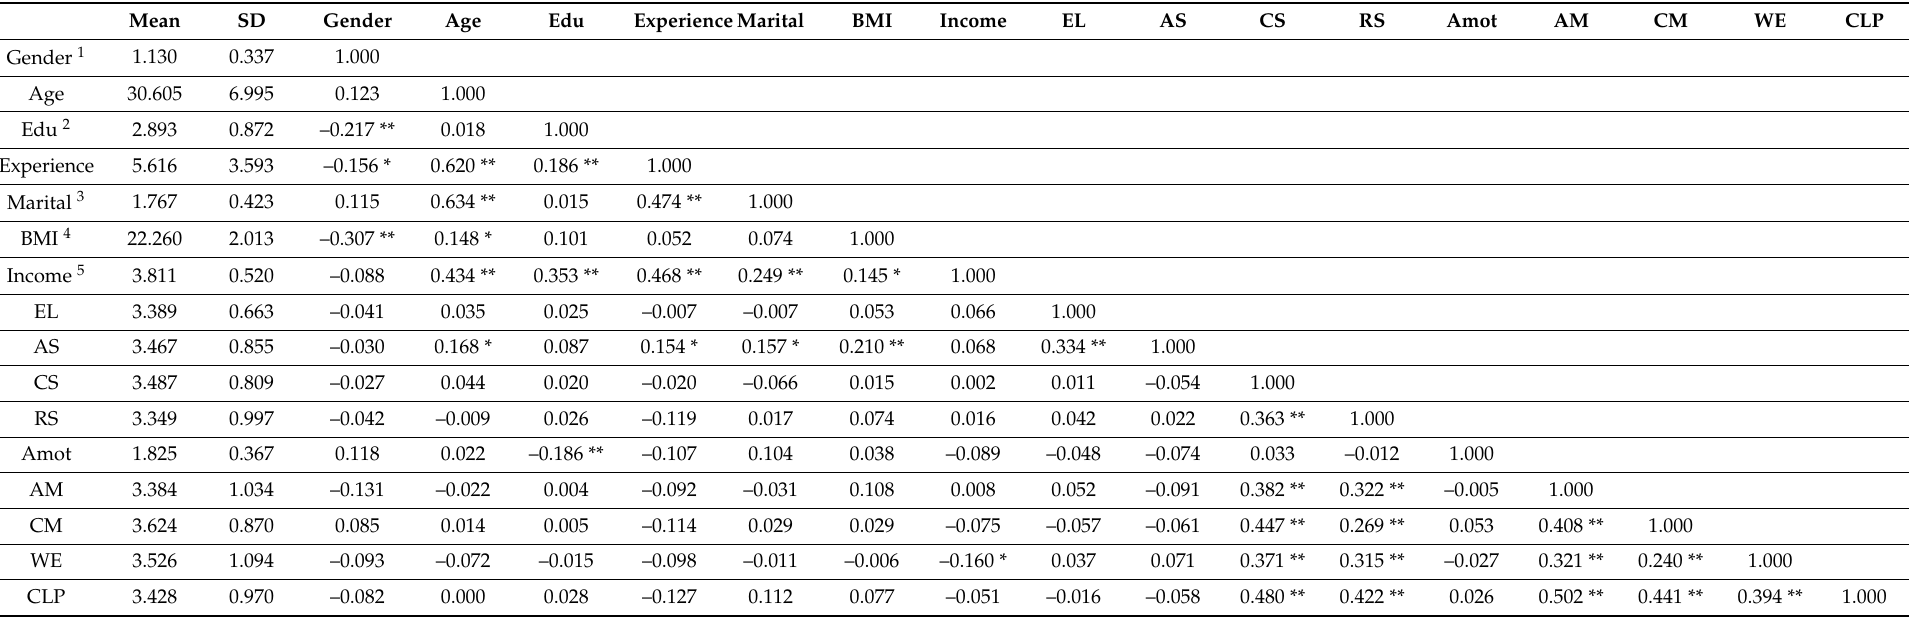
Table 3. Means, standard deviations and correlations between